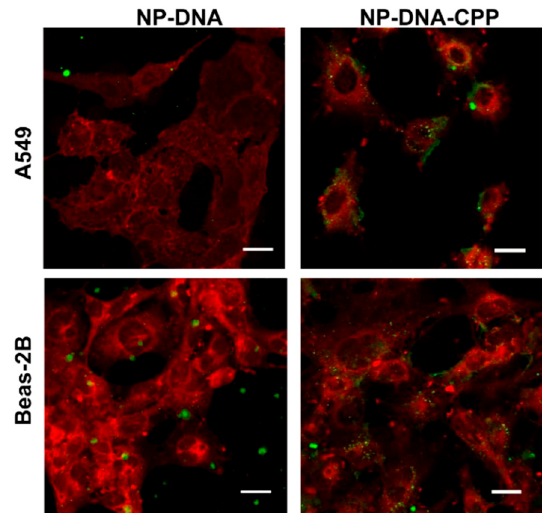
Figure 2. Confocal microscopy image of the cellular uptake of both NP–DNA and NP–DNA–CPP in both A549 and Beas-2B cells. (Red) Cellular membrane; (Green) NP–DNA and NP–DNA–CPP. Error bar indicates 20 µm.